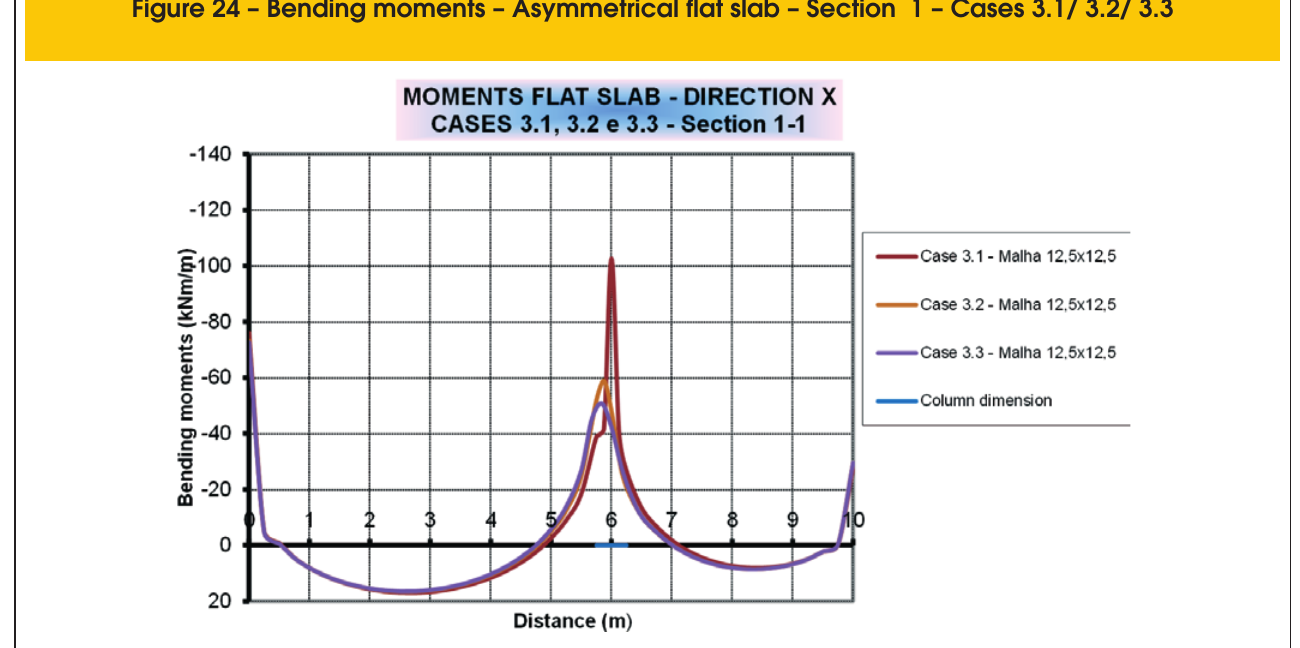
Figure 24 – Bending moments – Asymmetrical flat slab – Section 1 – Cases 3.1/ 3.2/ 3.3